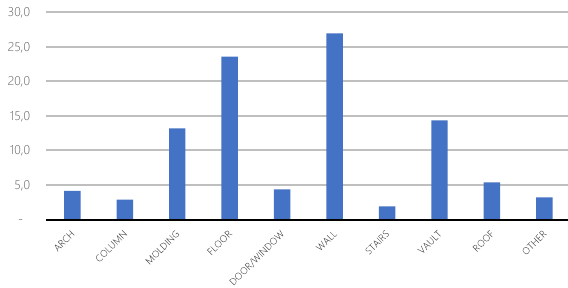
Table 1: General workflow of the developed